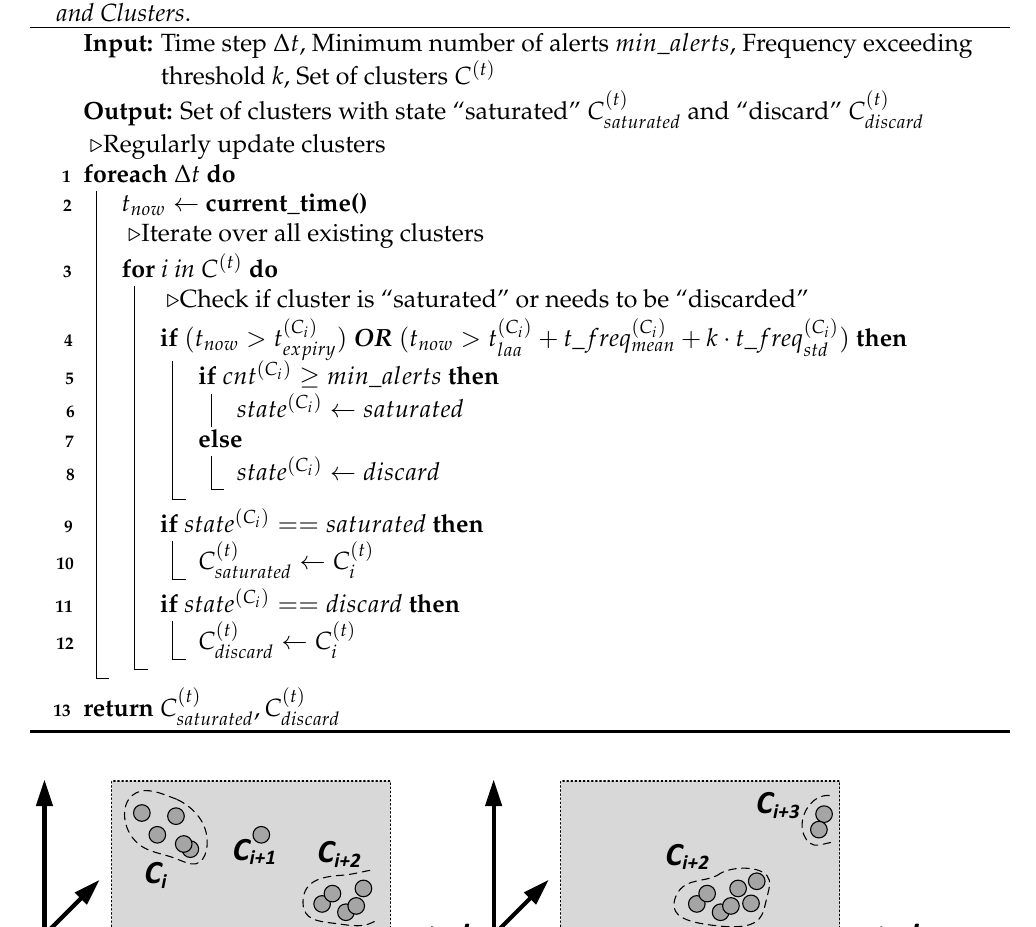
Algorithm 2: Monitoring of Trigger Signature Generation and Discard Alerts